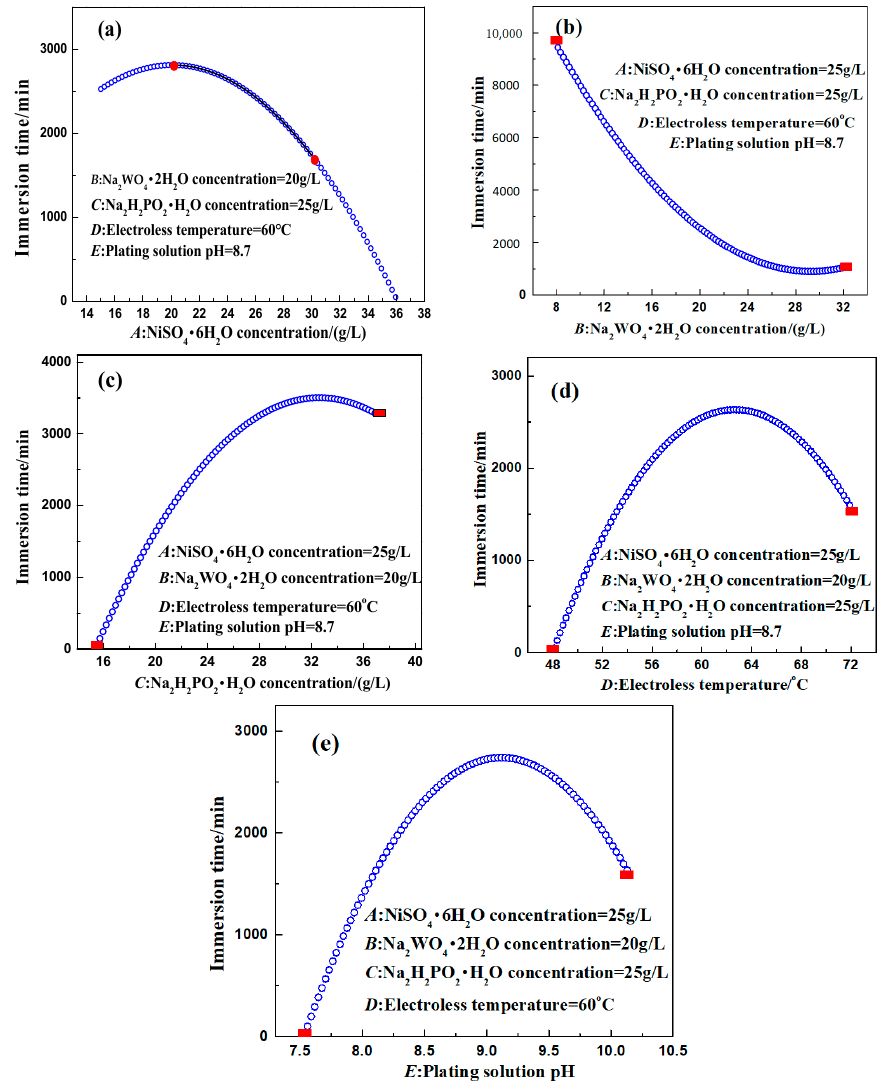
Figure 8. Relationship curves between different factors and the response value. ( a ) NiSO 4 ·6H 2 O; ( b ) Na 2 WO 4 ·2H 2 O; ( c ) NaH 2 PO 2 ·H 2 O; ( d ) Solution temperature; ( e ) Solution pH. ( b ) Na · 2H · H 2 WO 4 2 O; ( c ) NaH 2 PO 2 2 O; ( d ) Solution temperature; ( e ) Solution